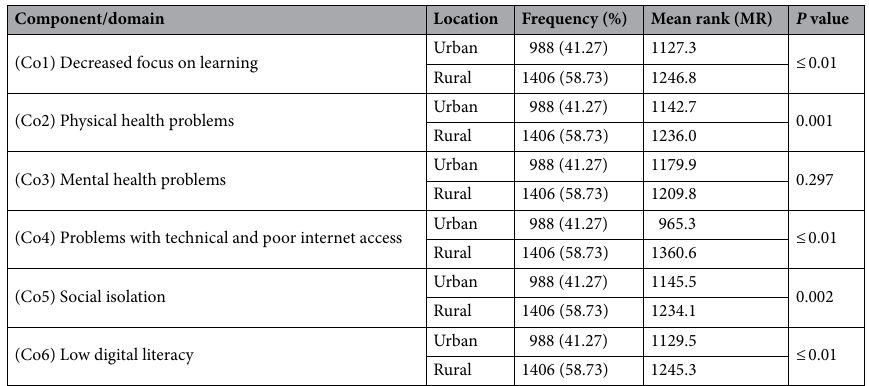
Table 4. Results of the Mann–Whitney U test. Mann–Whitney U ( p value) at the level of significance (α = 0.05).